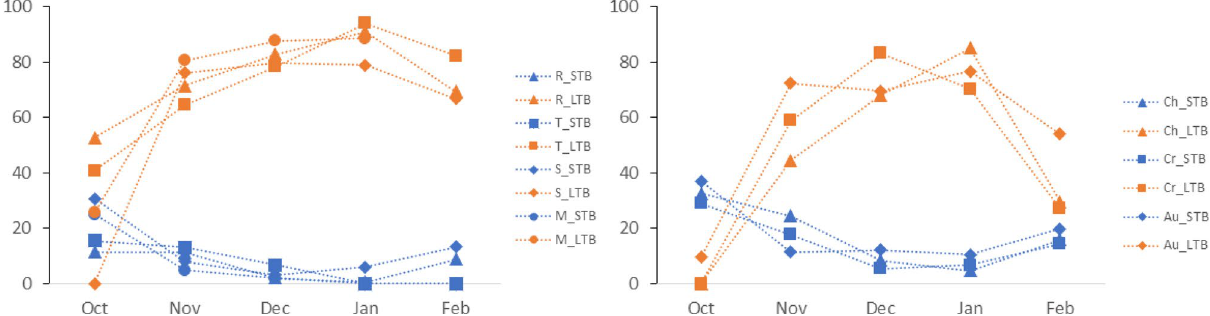
Figure 3. Hours spent in STB (in blue) vs. LTB (orange) per month, females on the left, males on the right, expressed in percentages.